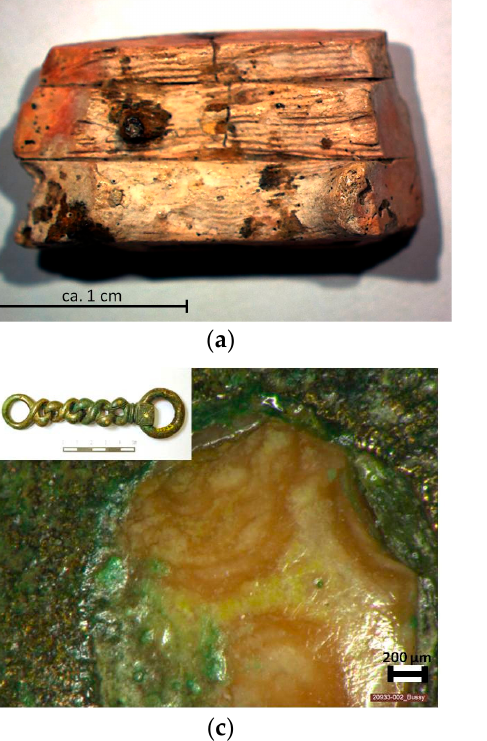
Figure 2. Examples of almost unprocessed corals from the Iron Age (~620–450 BC) in southwestern Germany. ( a ) Necklace from Tomb 122 of the Magdalenenberg tumulus near Villingen-Schwenningen (Schwarzwald-Baar-Kreis). A detail is shown in Figure 3e. ( b ) Pectoral necklace from a tumulus near Allensbach-Kaltbrunn (Landkreis Konstanz). ( c ) Piece of oddly circular-shaped coral branch from Burial 6 of the Hohmichele tumulus near Altheim-Heiligkreuztal. ( d ) Necklace of single coral pieces and egg-sized bulbs, composed of several lamellae from the burial of a young woman at Esslingen-Sirnau.